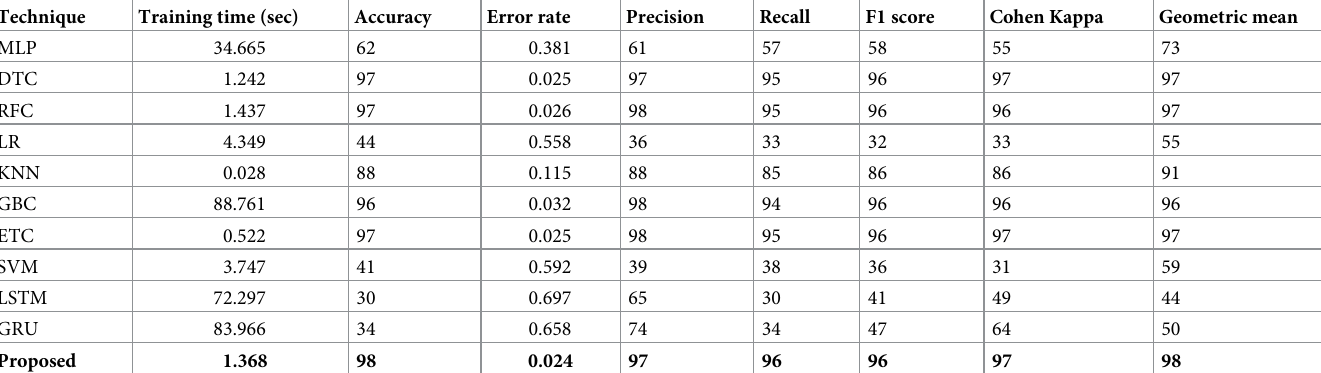
Table 4. Performance analysis of employed machine and deep learning techniques with the proposed technique. Technique